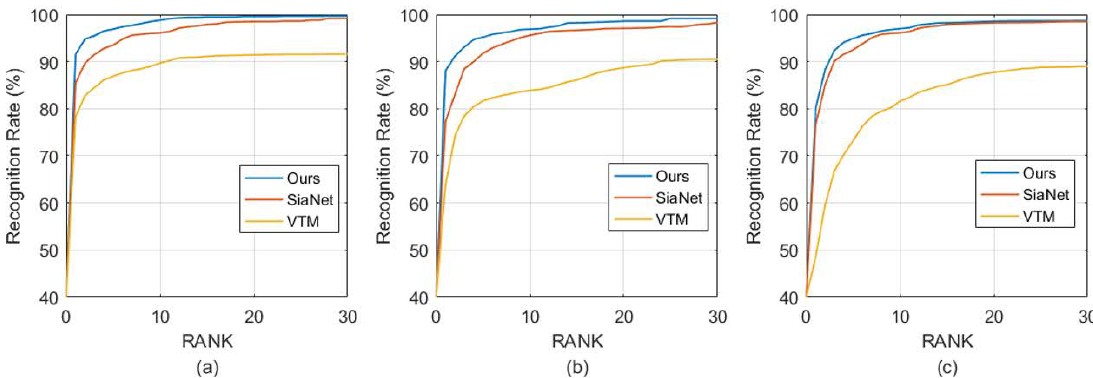
Figure 13: CMS-comparisons on cross-view gait recognition (%) on OU-ISIR-LP dataset. Galley viewing angle is 55 ∘ , and probe viewing angle is (a) 65 ∘ , (b) 75 ∘ , (c) 85 ∘ respectively.